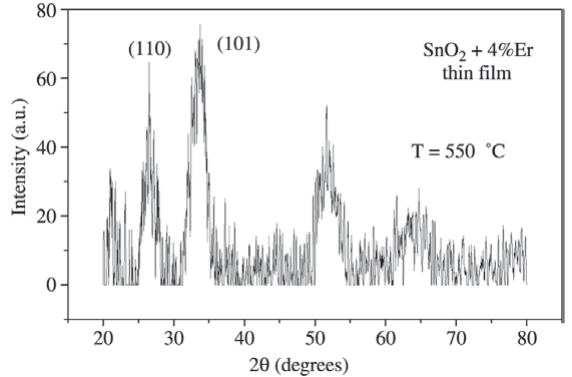
Figure 5. X-ray diffraction data for SnO at 550 °C.